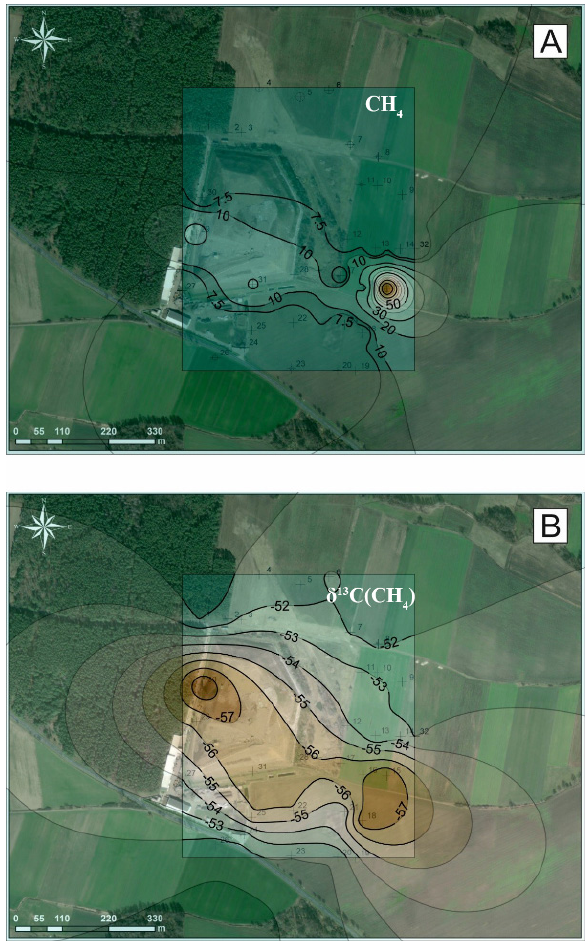
Figure 3. Spatial distribution of CH 4 mole fraction ( A ) and the δ 13 C(CH 4 ) values ( B ) in the vicinity of the municipal waste landfill sampled on 22 August 2017 campaign. Brightness rectangle covered sampling points, whereas the area outside has been extrapolated.